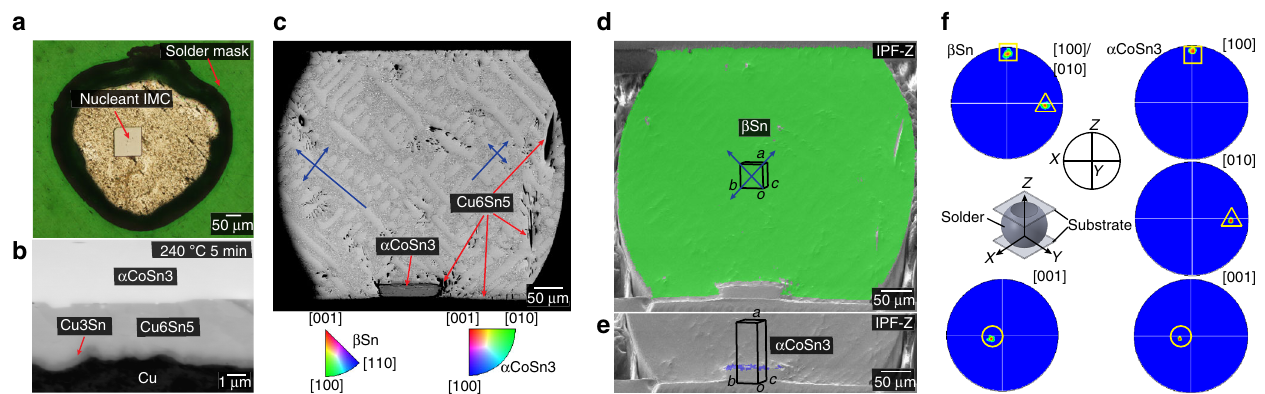
Fig. 5 Microstructure at different stages of processing in a Cu/Sn-3.5Ag + nucleant/Cu joint. a A typical immersion tin-coated Cu substrate with an IMC nucleant bonded on top. b Cross-section of a typical transient liquid phase bonded (TLPB) α CoSn 3 seed crystal (i.e., a cross-section through a ). c Cross- section of a typical Cu/Sn-3.5Ag + α CoSn 3 /Cu solder joint after double re fl ow. Blue arrows show < 110 > β Sn dendrite branching directions. d EBSD IPF-Z map of the β Sn phase. e EBSD IPF-Z map of the α CoSn 3 seed crystal. The unit cell orientation of each phase is superimposed on each map. f Pole fi gures of the β Sn and α CoSn 3 phases. The pairs of triangles, circles, and squares indicate the near-parallel planes that are consistent with the OR in Figs. 2c, 3